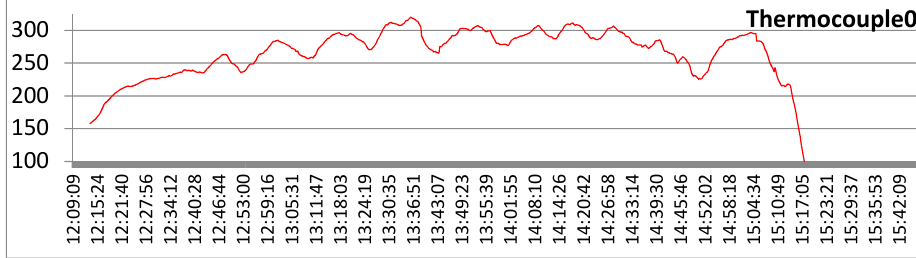
Figure 24. Temperature recorded with a thermocouple located inside the receiving pipe near the aphelion during a test day.